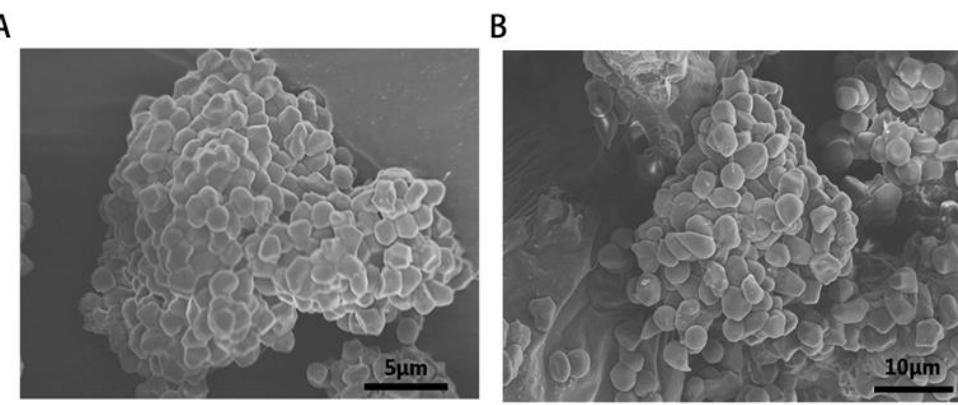
Figure 8. SEM images of erythrocyte agglutination and adhesion on the surfaces of ( A ) CaCO 3 -chitason and ( B ) CaCO 3 .